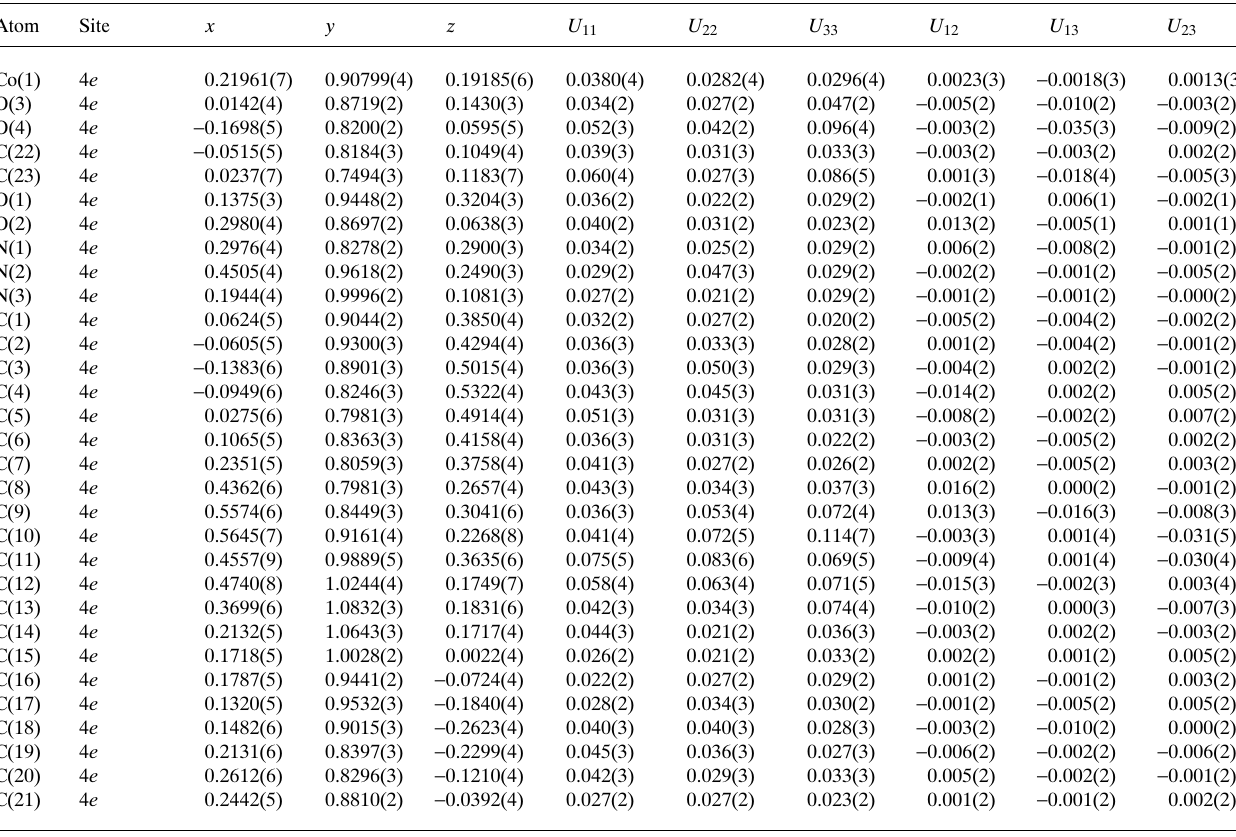
Table 3. Atomic coordinates and displacement parameters (in Å 2 )